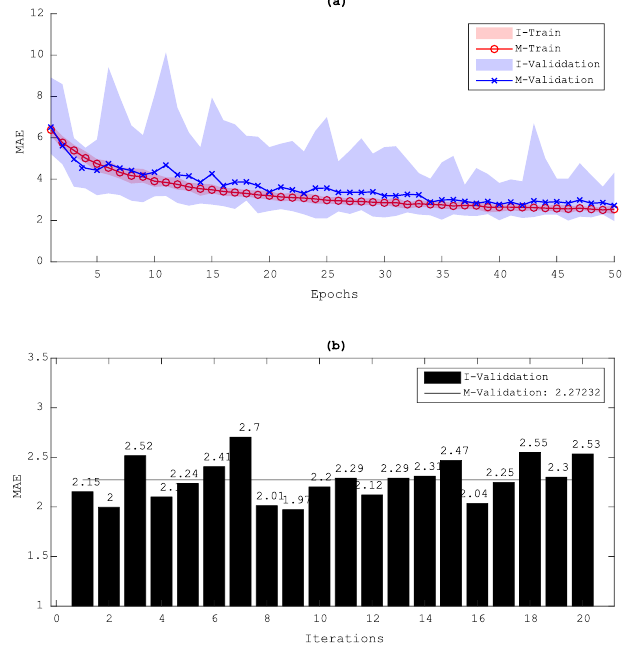
Figure 14. Evolution of the validation loss (MAE) during training for the D1 data set using data augmentation: ( a ) validation loss and ( b ) minimum MAE of each model and the averaged result; I, iteration model; M, Mean results of the I